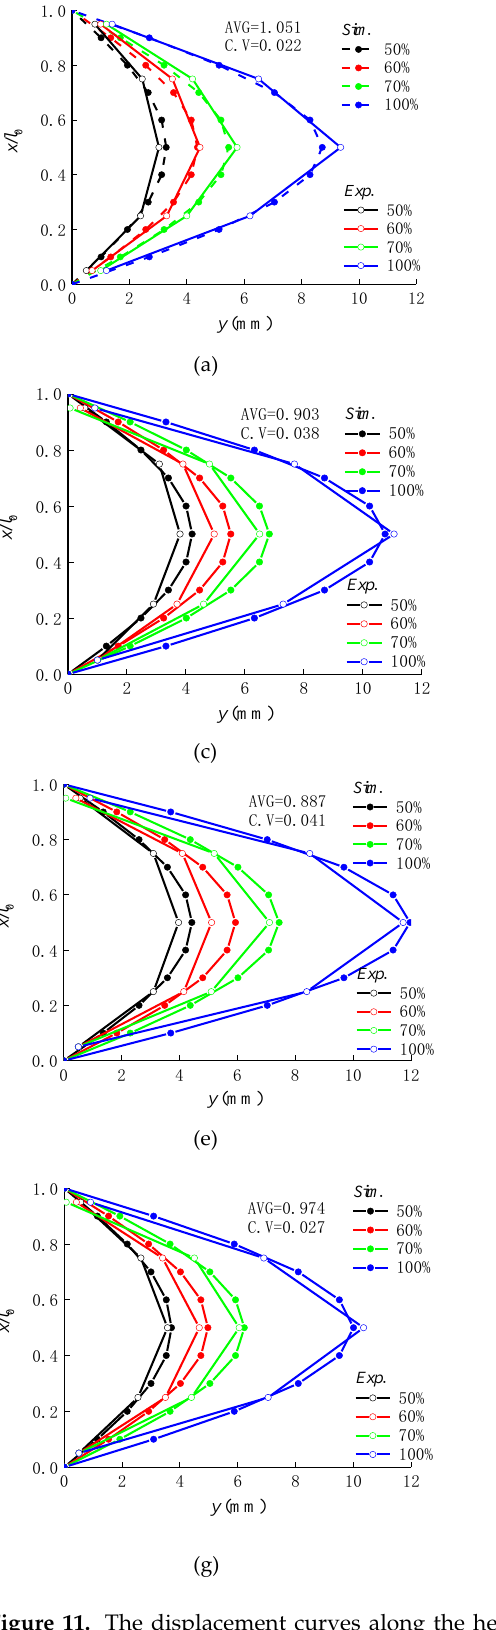
Figure 11. The displacement curves along the height of the columns: ( a ) C30-1.2A; ( b ) C30-1.2B; ( c ) C40-1.2A; ( d ) C40-1.2B; ( e ) C50-1.2A; ( f ) C50-1.2B; ( g ) C40-1.6; ( h )